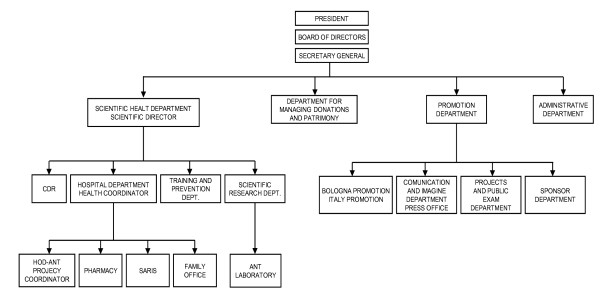
The structure of the ANT organization (see text for details).